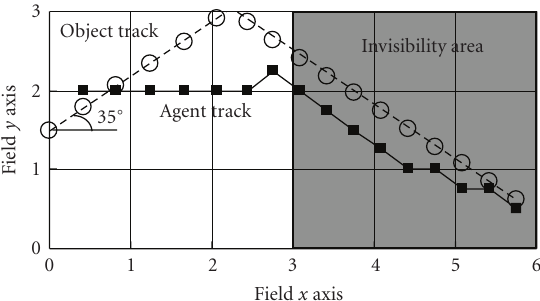
Figure 4: Sample object and agent trajectories for the object moving at 35 ◦ with a velocity of 0.50/step, and the object cannot be seen at x > 3 . 0. The agent does not move in the x direction actually, but for easy understanding, it is shown to be moving in the x direction along with the object.